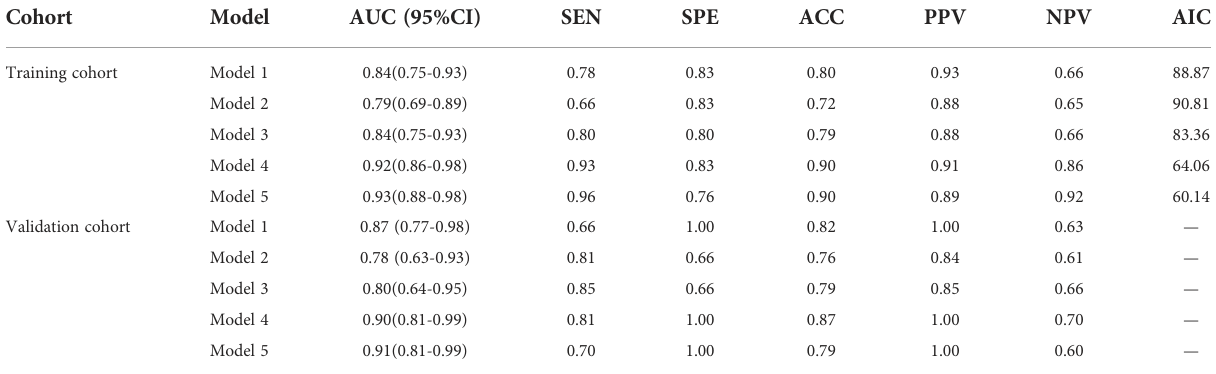
TABLE 2 Prediction performance of model